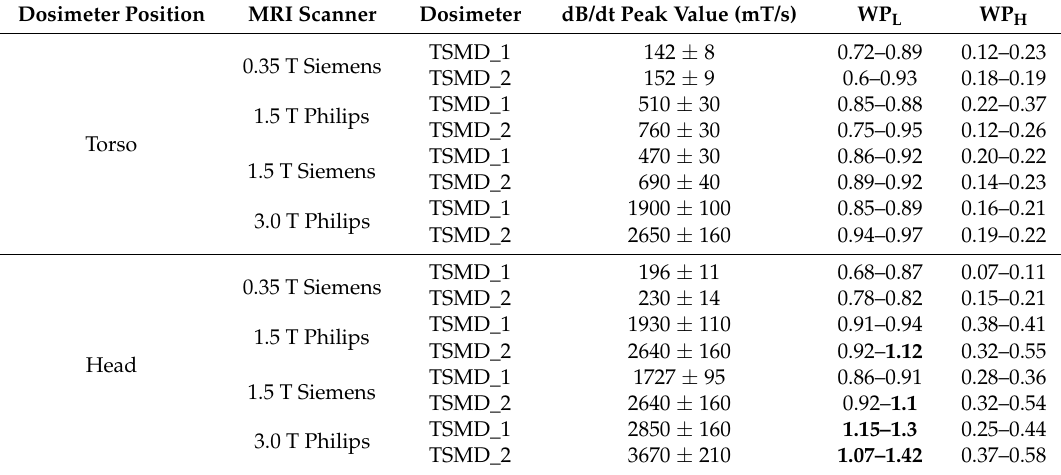
Table 4. dB/dt peak values and WP L and WP H indexes refer to routine procedures. Bold values indicate noncompliance with regulatory